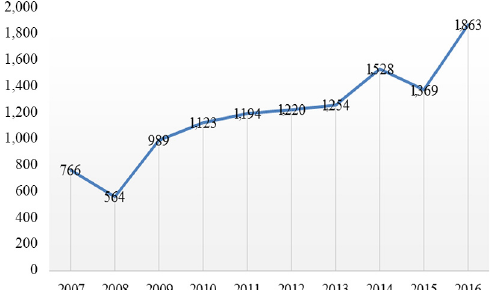
Figure 1. Annual